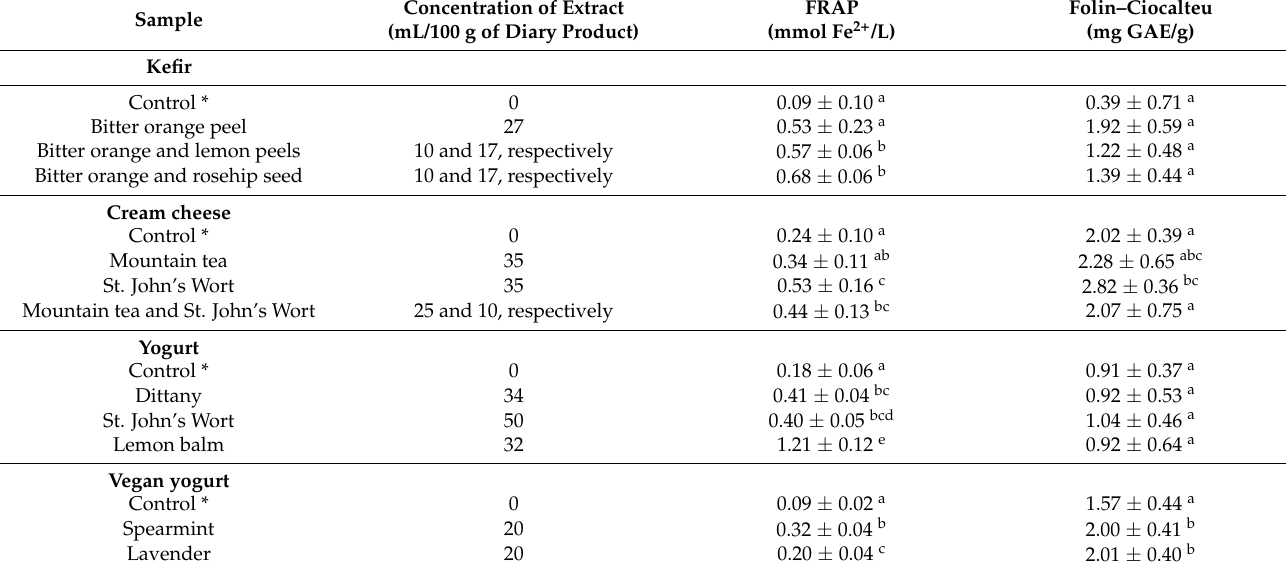
Table 6. Total antioxidant and phenolic content in fortified food products after in vitro